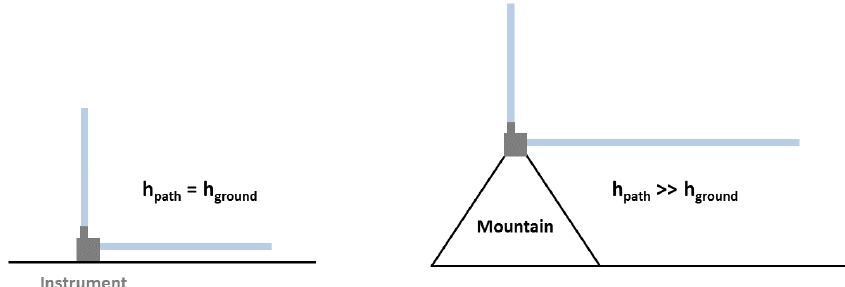
Figure 1. Schematic illustration of the MAX-DOAS observation geometry in a typical urban and/or rural setting (left) and in mountainous terrain (right). While the altitude of the instrument’s horizontal path ( h path ) corresponds to the ground level ( h ground ) of the surrounding area in the left sketch, h path is larger than h ground in the right graph.